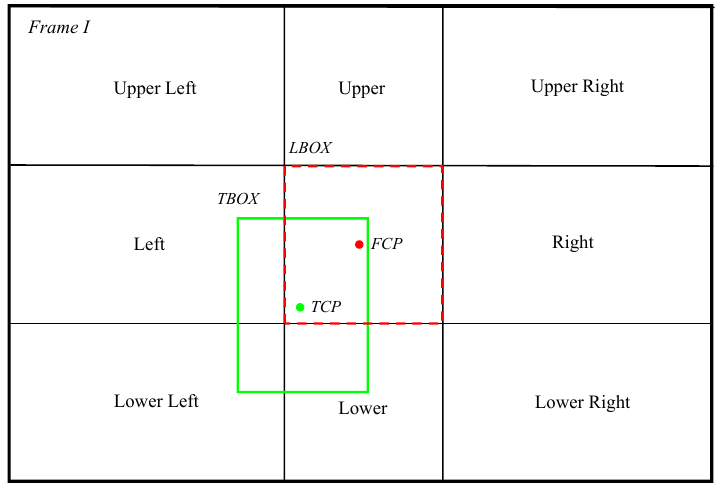
Figure 4. Positive control schematic. The UAR movement is controlled according to the position of the target center TCP , and the TCP is kept in the center of the frame LBOX